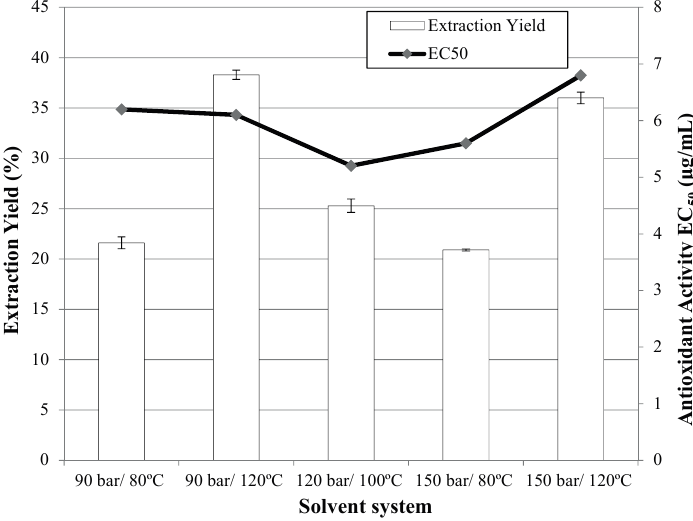
Figure 4. Extraction yield and antioxidant activity obtained by PLE with ethanol/water (50:50) from Petit Verdot grape pomace under different extraction conditions at a flow rate of 10 g/min during 3 h of